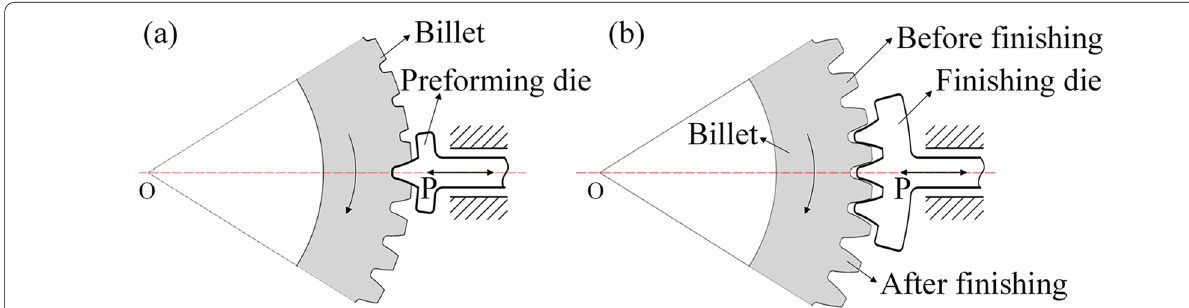
Figure 1 Principles of two stages: (a) preforming stage and (b) finishing